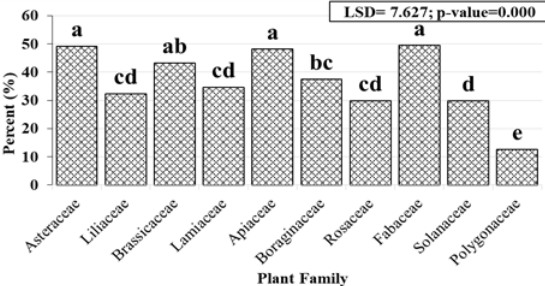
Fig. 3. Comparison between the antioxidant capacity of plant family regardless of plant species by DPPH method.